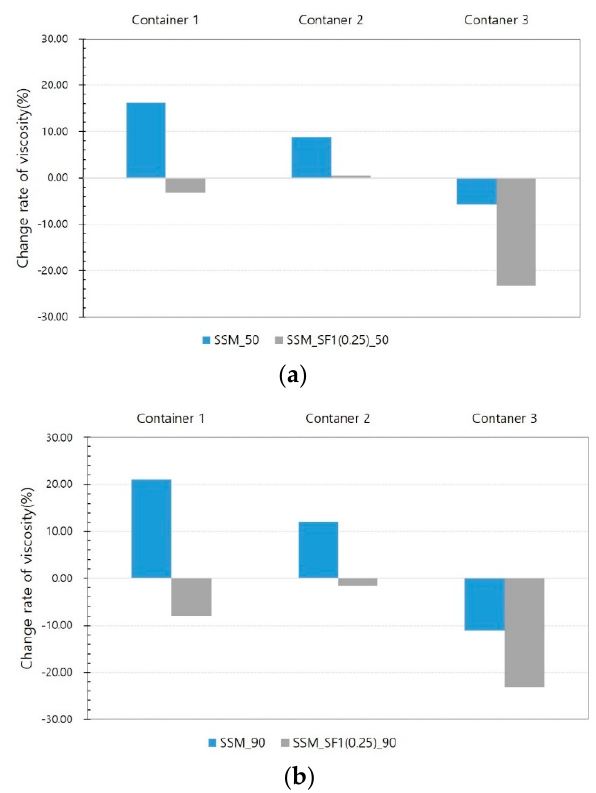
Figure 14. Viscosity results from Phase II test: ( a ) at 50 V, ( b ) at 90 V. The viscosity of SSM_SF1 (0.25) was not significantly reduced in containers 1 and 2 but decreased significantly in container 3. This result demonstrates that the rheology of SSM and SSM_SF is significantly affected by the application method of the magnetic field.